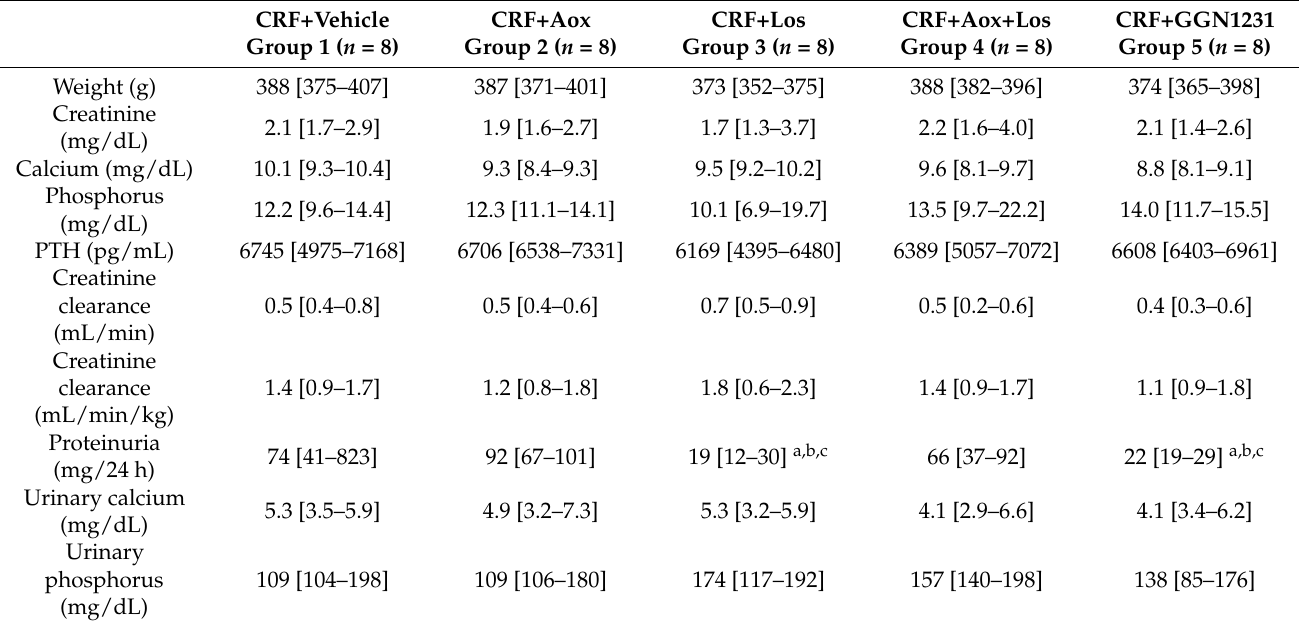
Table 1. Weight and biomarkers of kidney